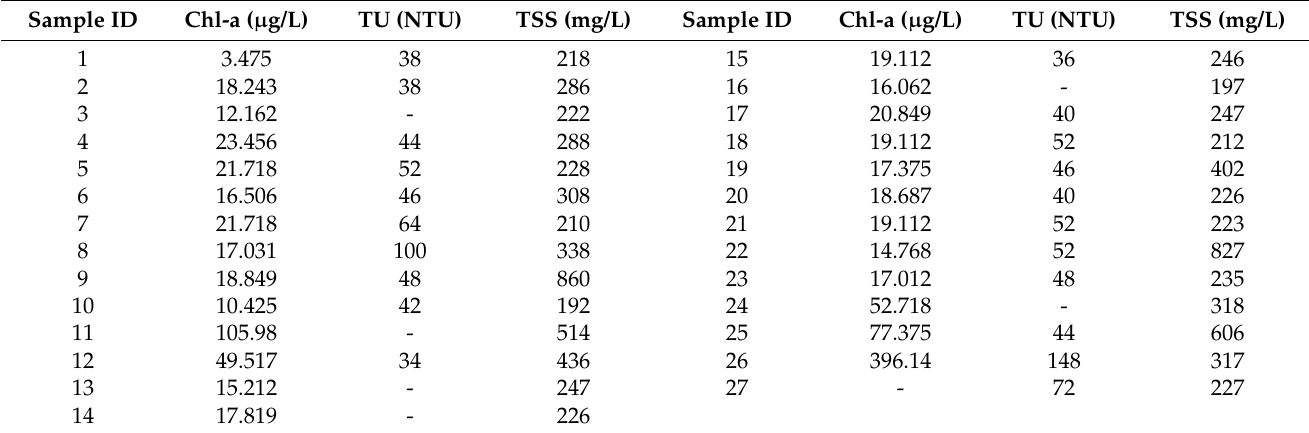
Table 2. Laboratory water quality parameters results averaged from the three